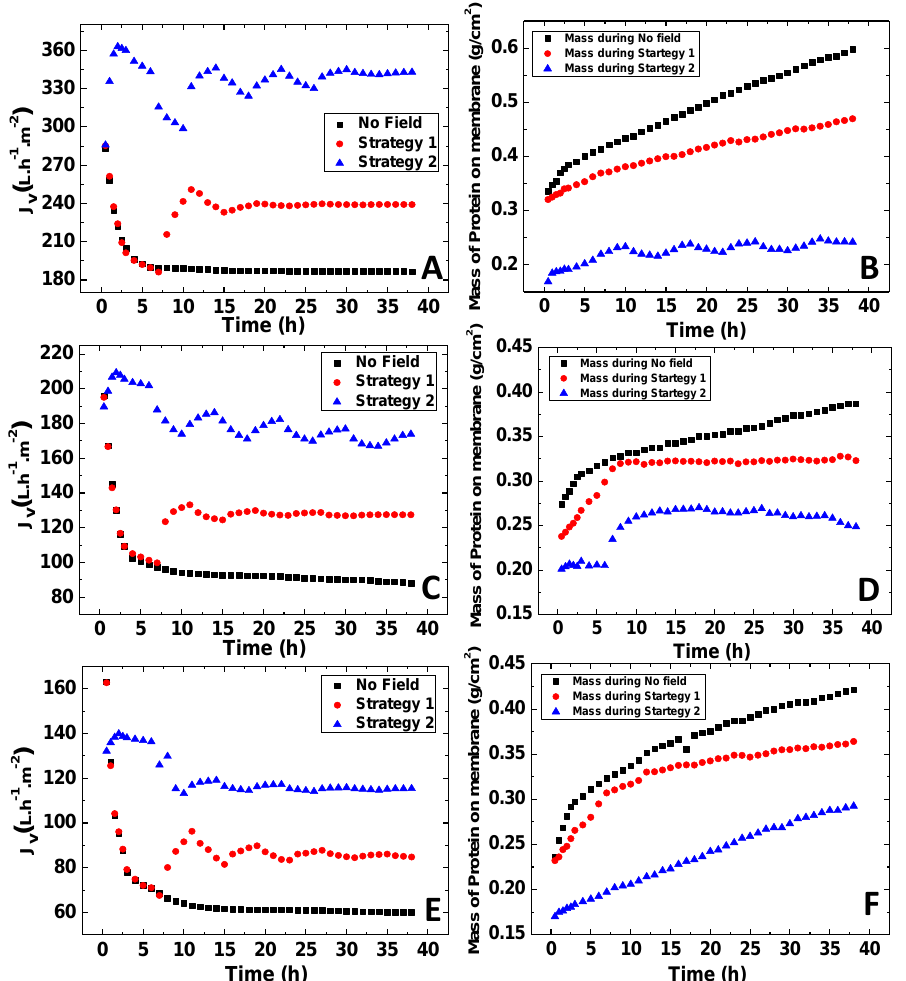
Figure 6. Permeate flux behavior and mass of protein retained in the membrane plotted versus time for: ( A and B ) Membrane made out of spheres from PISA strategy, ( C and D ) membrane prepared by NIPS procedure containing PMAA 47 -coated NPs, and ( E and F ) membrane prepared by NIPS procedure containing DMSA-coated NPs, obtained at a TMP of 3 bar.